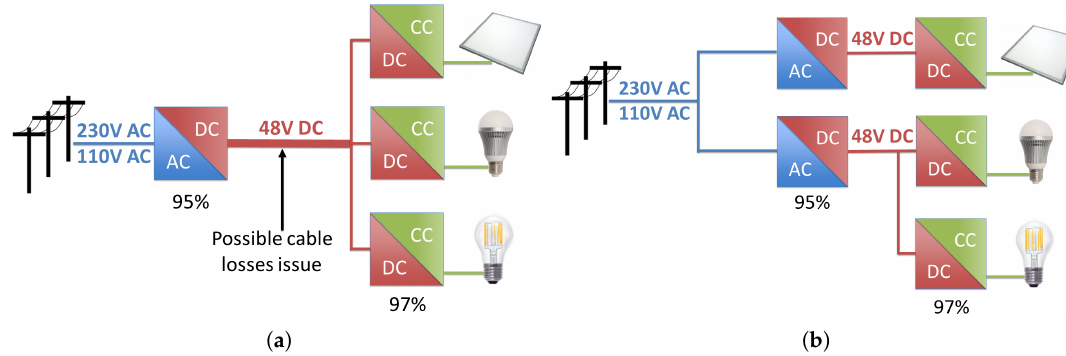
Figure 11. Two EDISON powering approaches. Approach b reduces the cable loss issue. (CC stands for constant current, which is provided by the LED drivers). ( a ) common 48 V DC grid powering multiple zones; ( b ) multiple well located smaller and shorter 48 V DC grids using AC mains as distribution